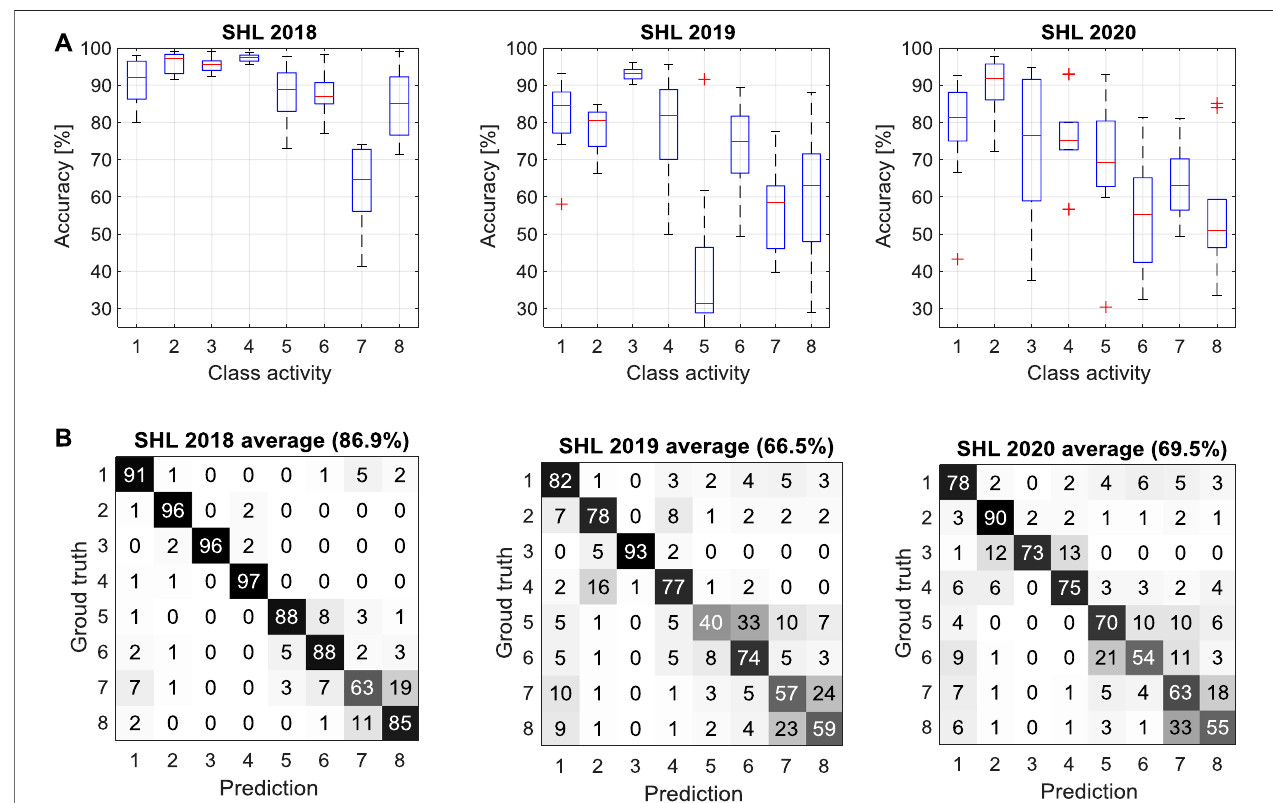
FIGURE 10 | Average performance of the top 10 teams in SHL 2018 – 2020. (A) Recognition accuracy for each class activity. (B) Average confusion matrix. The eight class activities are: 1 — Still; 2 — Walk; 3 — Run; 4 — Bike; 5 — Car; 6 — Bus; 7 — Train; 8 — Subway. The boxplot illustrates the minimum, fi rst quartile, median, third quartile, and maximum values in each group of data, and the also the outlier